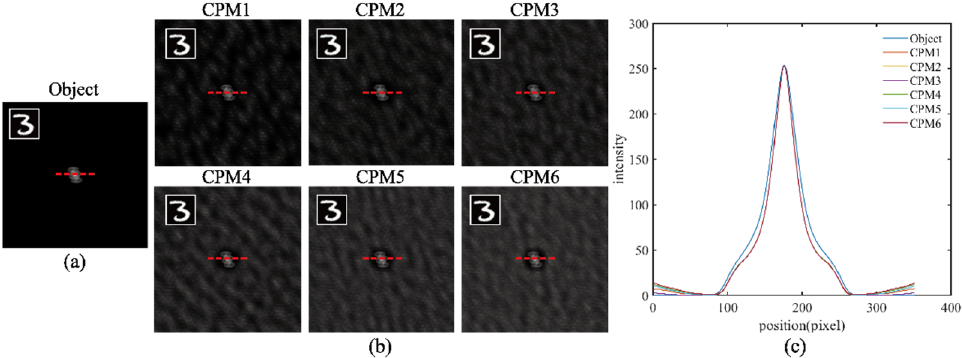
Figure 3. Autocorrelation analysis of the same object corresponding to different CPMs. ( a ) The autocorrelation of object; ( b ) The autocorrelation of speckle; ( c ) Profiles of the red dashed lines in ( a , b ).